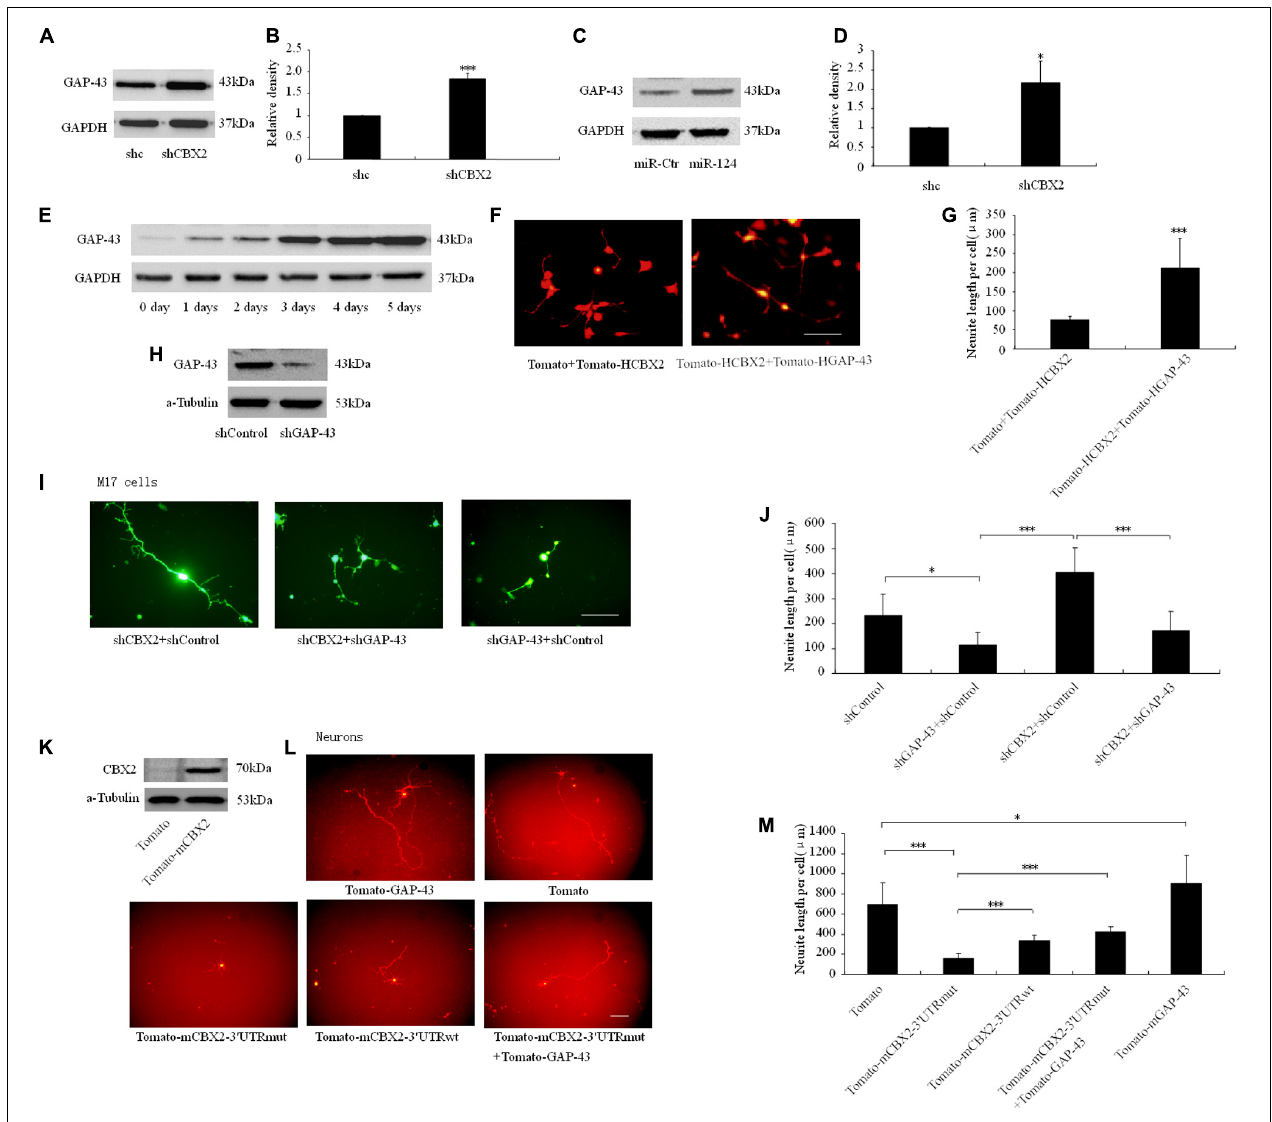
FIGURE 6 | CBX2 regulated neurite development involves GAP43. Immunoblotting analysis (A) and quantification result (B) shown that CBX2 knocked-down induces an increase in GAP-43 protein levels. Immunoblotting analysis (C) and quantification result (D) shown that miR-124 overexpression induces an increase in GAP-43 protein levels. (E) An immunoblot shows that an increase in GAP-43 protein levels during M17 cell neuronal differentiation. (F) Cell morphology of M17 cells transfected with the indicated constructs was monitored on the 3rd day after neuronal differentiation by observing the Td-tomato fluorescence. Scale bar: 100 µ m. (G) GAP-43 overexpression rescued the neurite inhibting effect of CBX2 overexpression in differentiated M17 cells. The data are presented as mean ± SD, n = 30 cells, ∗∗∗ P < 0.001. (H) Immunoblotting for GAP-43 expression showed that shGAP-43 reduced the amount of endogenous GAP-43 in M17 cells. M17 cells were co-transfected with each construct as indicated in the picture and the MCS-EF1-copGFP-T2A-puro vector by using Lipofectamine 2000 reagent. Puromycin was added to the culture medium 24 h later at a concentration of 1 µ g/ml to eliminate non-transfected cells. Immunoblotting analysis was preformed 72 h later. (I) Cell morphology of M17 cells transfected with the indicated constructs was monitored on the 3rd day after neuronal differentiation by observing the GFP fluorescence. Scale bar: 100 µ m. (J) GAP-43 knocked-down attenuated the neurite stimulating effect of CBX2 silencing in differentiated M17 cells. The data are presented as mean ± SD, n = 30 cells, ∗∗∗ P < 0.001. (K) Validation of mouse CBX2 protein expression of indicated constructs detected by Western Blot using the anti-CBX2 antibody in P19 cells. (L) The morphology of primary neurons transfected with the indicated vectors was monitored by Td-tomato fluorescence. (M) Quantification of the neurite length of the indicated groups is shown. Scale bar: 100 µ m. The data are presented as mean ± SD, n = 30 cells, ∗ P < 0.05, ∗∗∗ P <